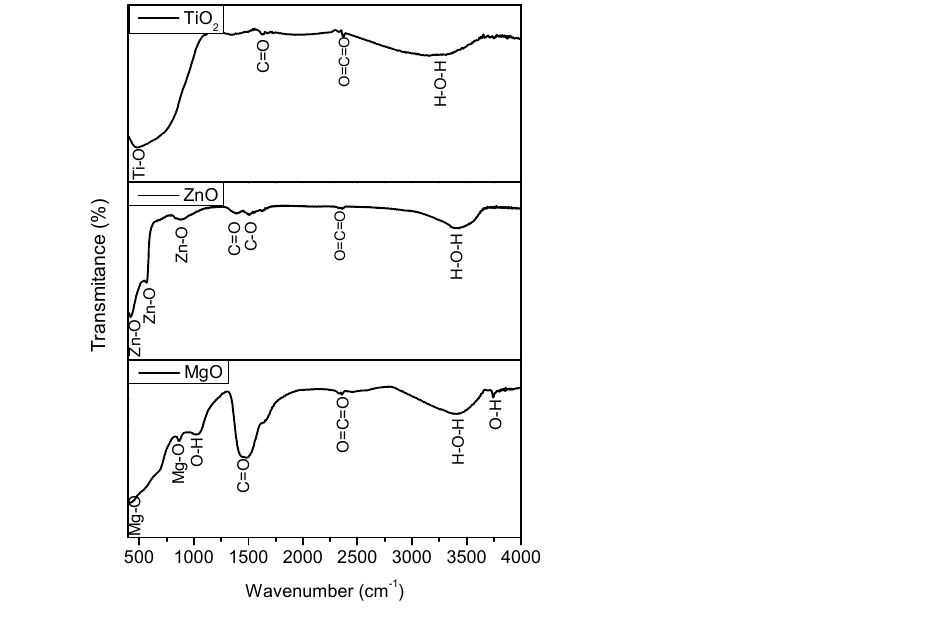
Figure 2. The transmission FTIR spectra of TiO 2 , ZnO, and MgO synthesized through sol-gel method.